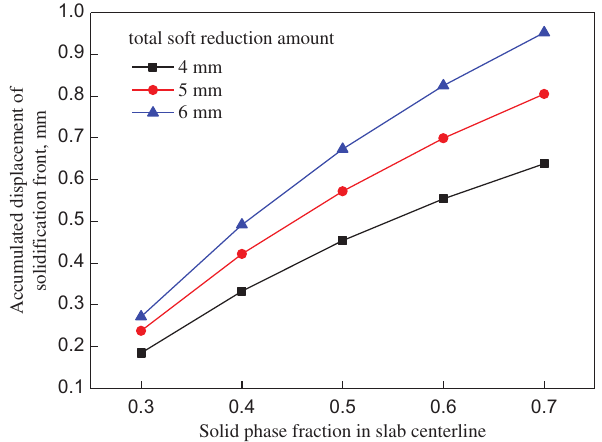
Figure 13: Relationship between accumulated displacement of soli- dification front and solid phase fraction in slab centerline.